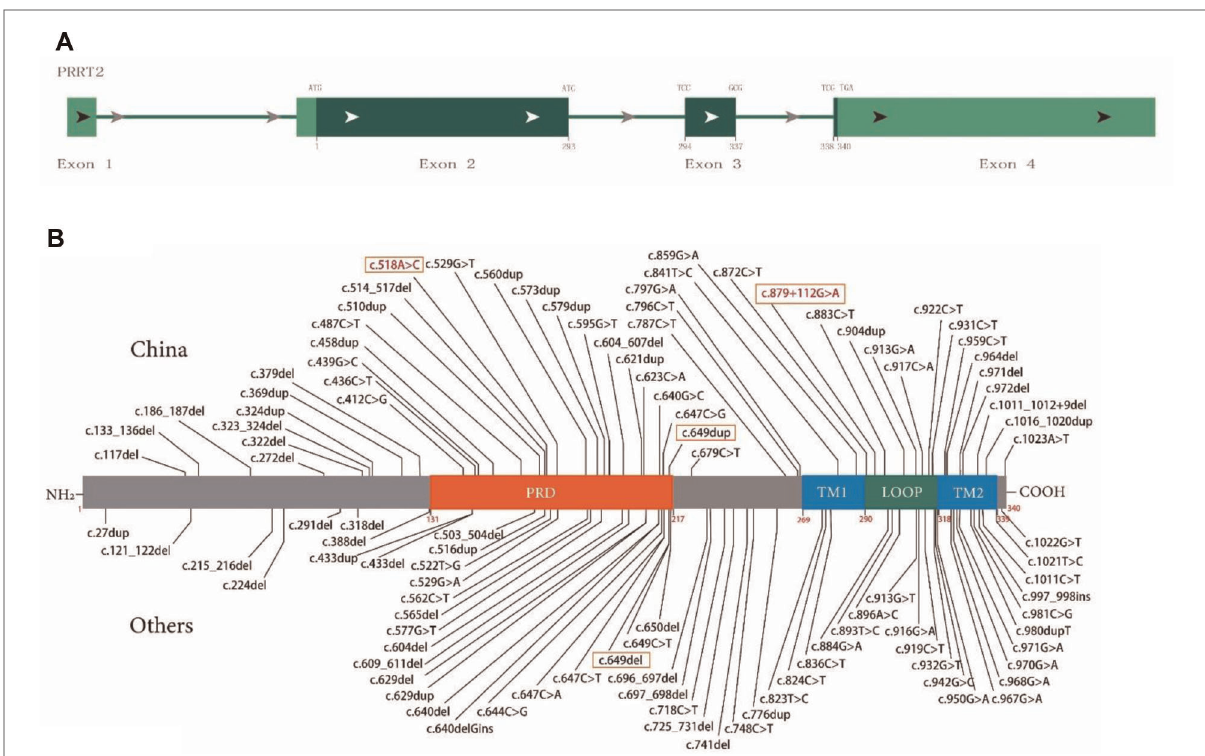
FIGURE 3 Schematic diagram of proline-rich transmembrane protein 2 (PRRT2) mutation map and protein domain superposition. ( A ) PRRT2 is composed of four exons, exons 2 – 4 encode multidomain protein containing 340 amino acids. ( B ) Main domains of PRRT2 protein: PRD (orange, 131 – 216), proline-rich domain; TM1 (blue, 269 – 289), transmembrane domain 1; TM2 (blue, 318 – 338), transmembrane domain 2; Loop (green, 290 – 317), domain between TM1 and TM2. Text box shows mutations reported in this article, where red font indicates new